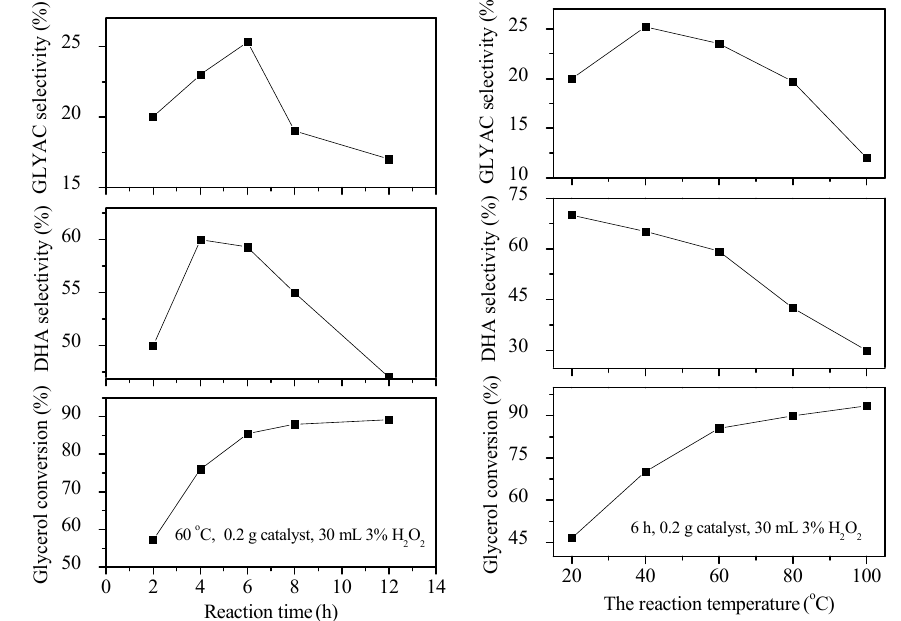
Figure 5. Effect of the condition parameters on the catalytic performance of Cr(SO 3 -salen)-CuMgAl-LDH.